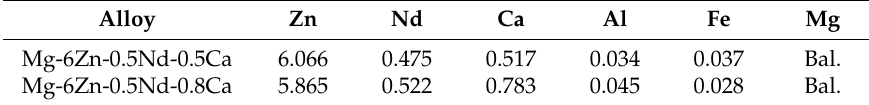
Table 1. Chemical composition of the extruded alloys, wt%.